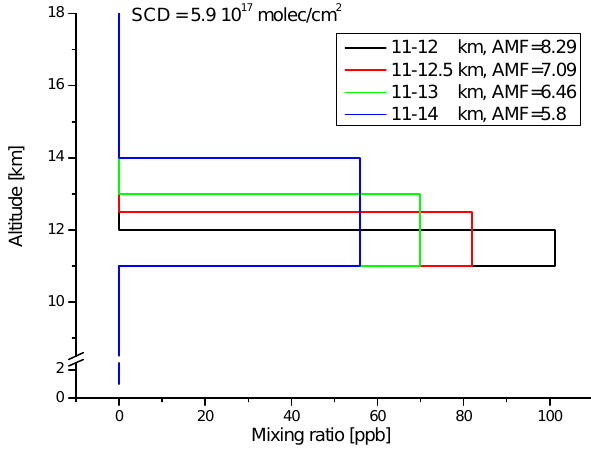
Fig. 8. SO 2 box profiles, that lead to the observed SCD of 5.9 × 10 17 molec/cm 2 . The black line illustrates a profile from 11 to 12km, red reaches 11 to 12.5km, green between 11 and 13km and in blue from 11 to 14km. Depending on the plume thickness, the total AMF varies between 8.3 and 5.8. Again no aerosols above the clouds are included in the simulations.